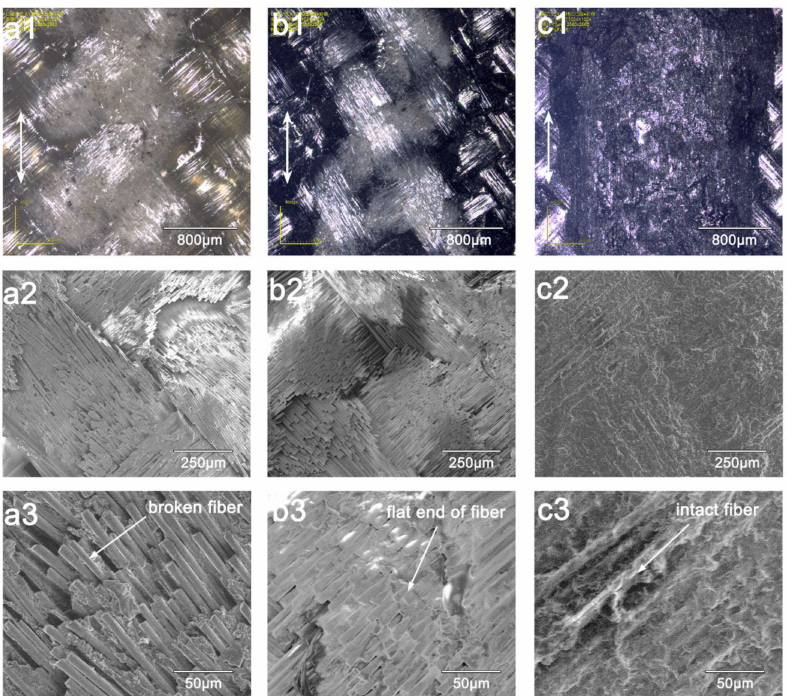
Figure 7. SEM images of worn surfaces of composites: ( a ) Raw GFRP, ( b ) I-0.4 g, ( c ) C-0.4